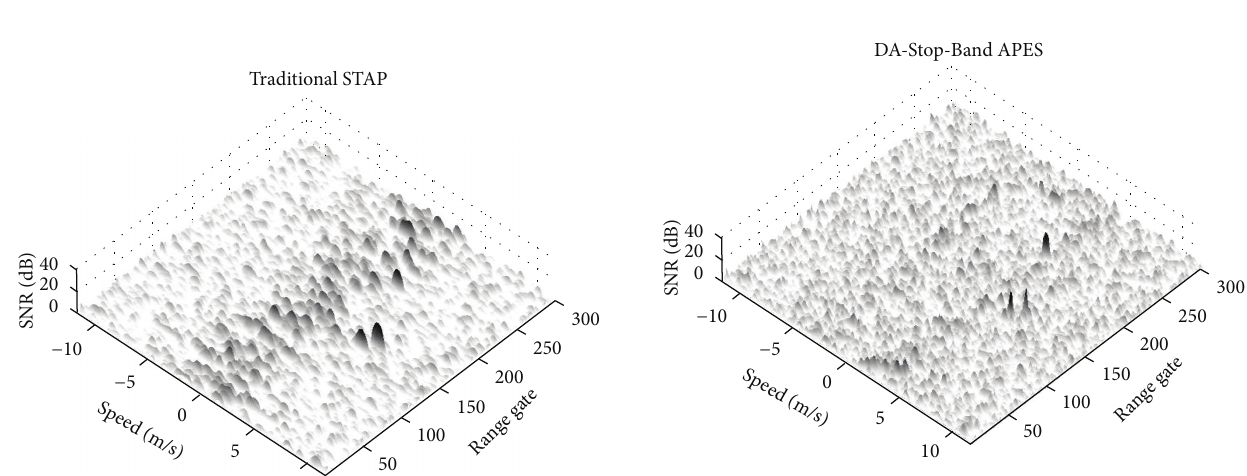
Figure 13: Range-Doppler map on RAMSES data showing the performance of the deterministic aidedc Stop Band